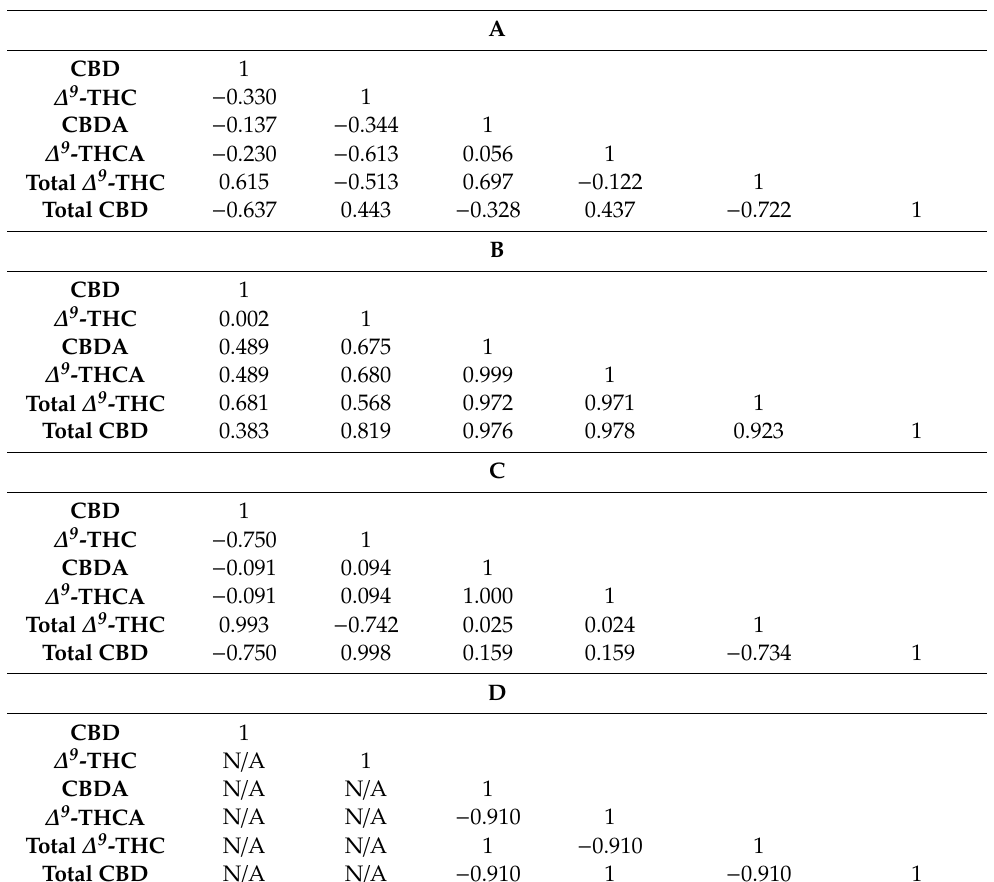
Table 3. Intra-variable correlation (Pearson’s correlation coe ffi cients) between major cannabinoid concentrations in the cannabis extracts from dried cannabis ( A ), cannabis oils ( B ), cannabis extracts using MAE ( C ) and SFE ( D ). Note: Total ∆ 9 -THC = ∆ 9 -THC + ∆ 9 -THCA Content; Total CBD = CBD + CBDA Content. CBD ∆ 9 -THC CBDA ∆ 9 -THCA Total ∆ 9